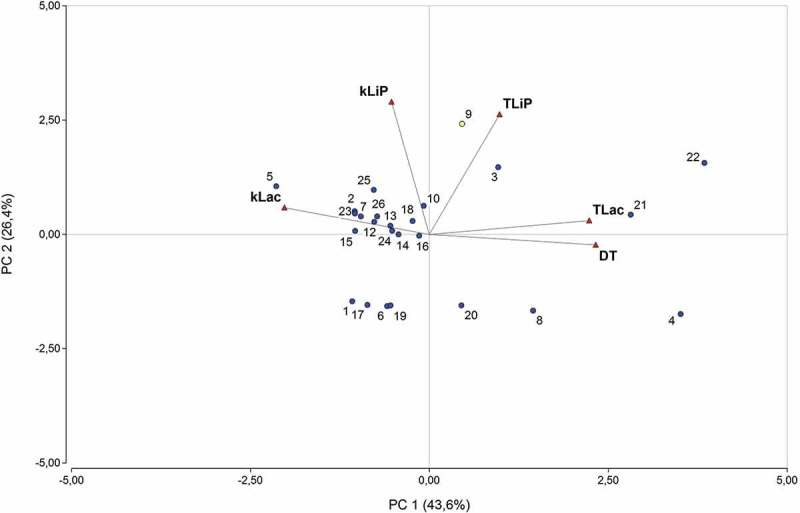
Score plot of PC1 vs PC2 illustrating the distribution of WRF, plotting after the elimination of kMnP and τMnP. Fungal identification numbers are displayed in Table 1.